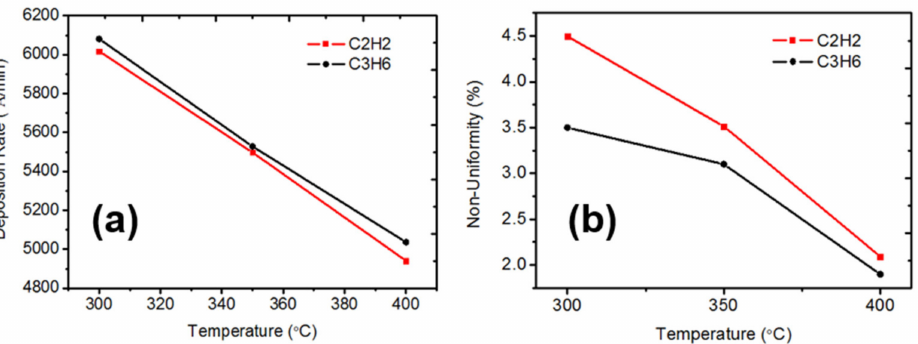
Figure 1. The profile of ( a ) deposition rate and ( b ) non-uniformity with the increase of deposition